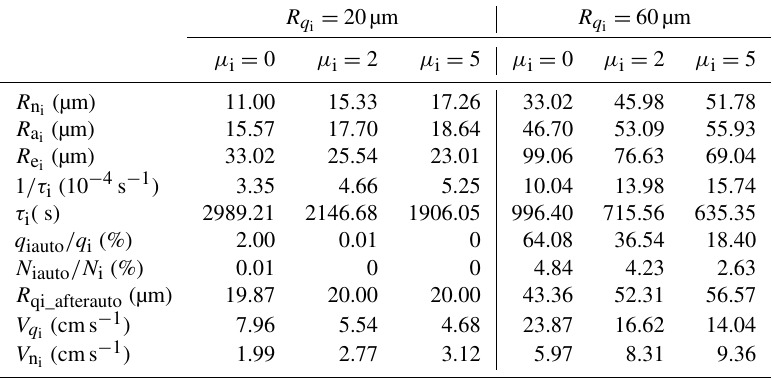
= 20µm (left) and R q i